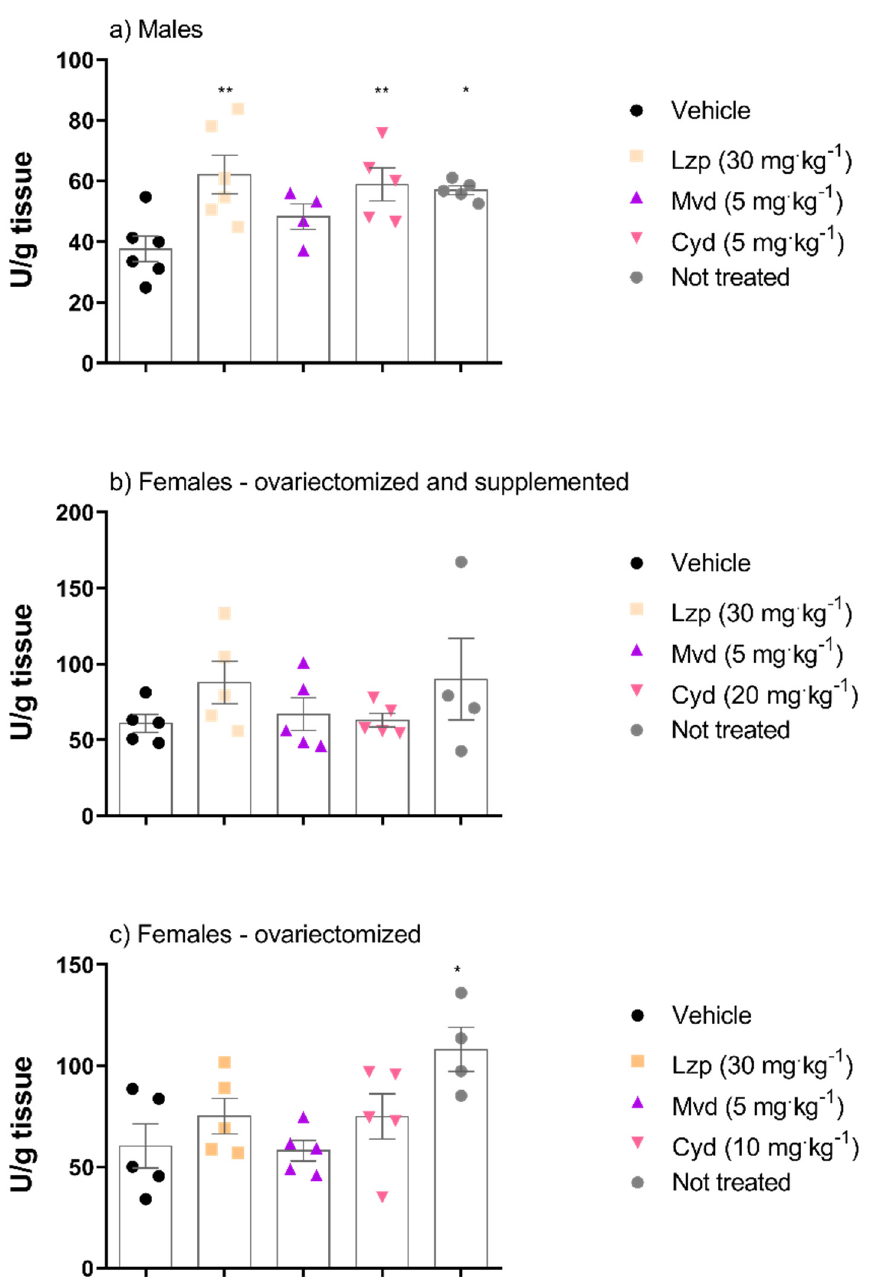
Figure 7. CAT activity in the gastric tissue of mice treated with malvidin and cyanidin chloride before gastric lesions induced by absolute ethanol in the different groups: ( a ) male animals, ( b ) female animals ovariectomized and supplemented with 17 β -estradiol (500 µ g/kg) and ( c ) group of ovariectomized female animals without supplementation. Data are presented as mean ± S.E.M. ANOVA followed by the Dunnett’s test; where * p < 0.05 and ** p < 0.01, compared to the respective vehicle